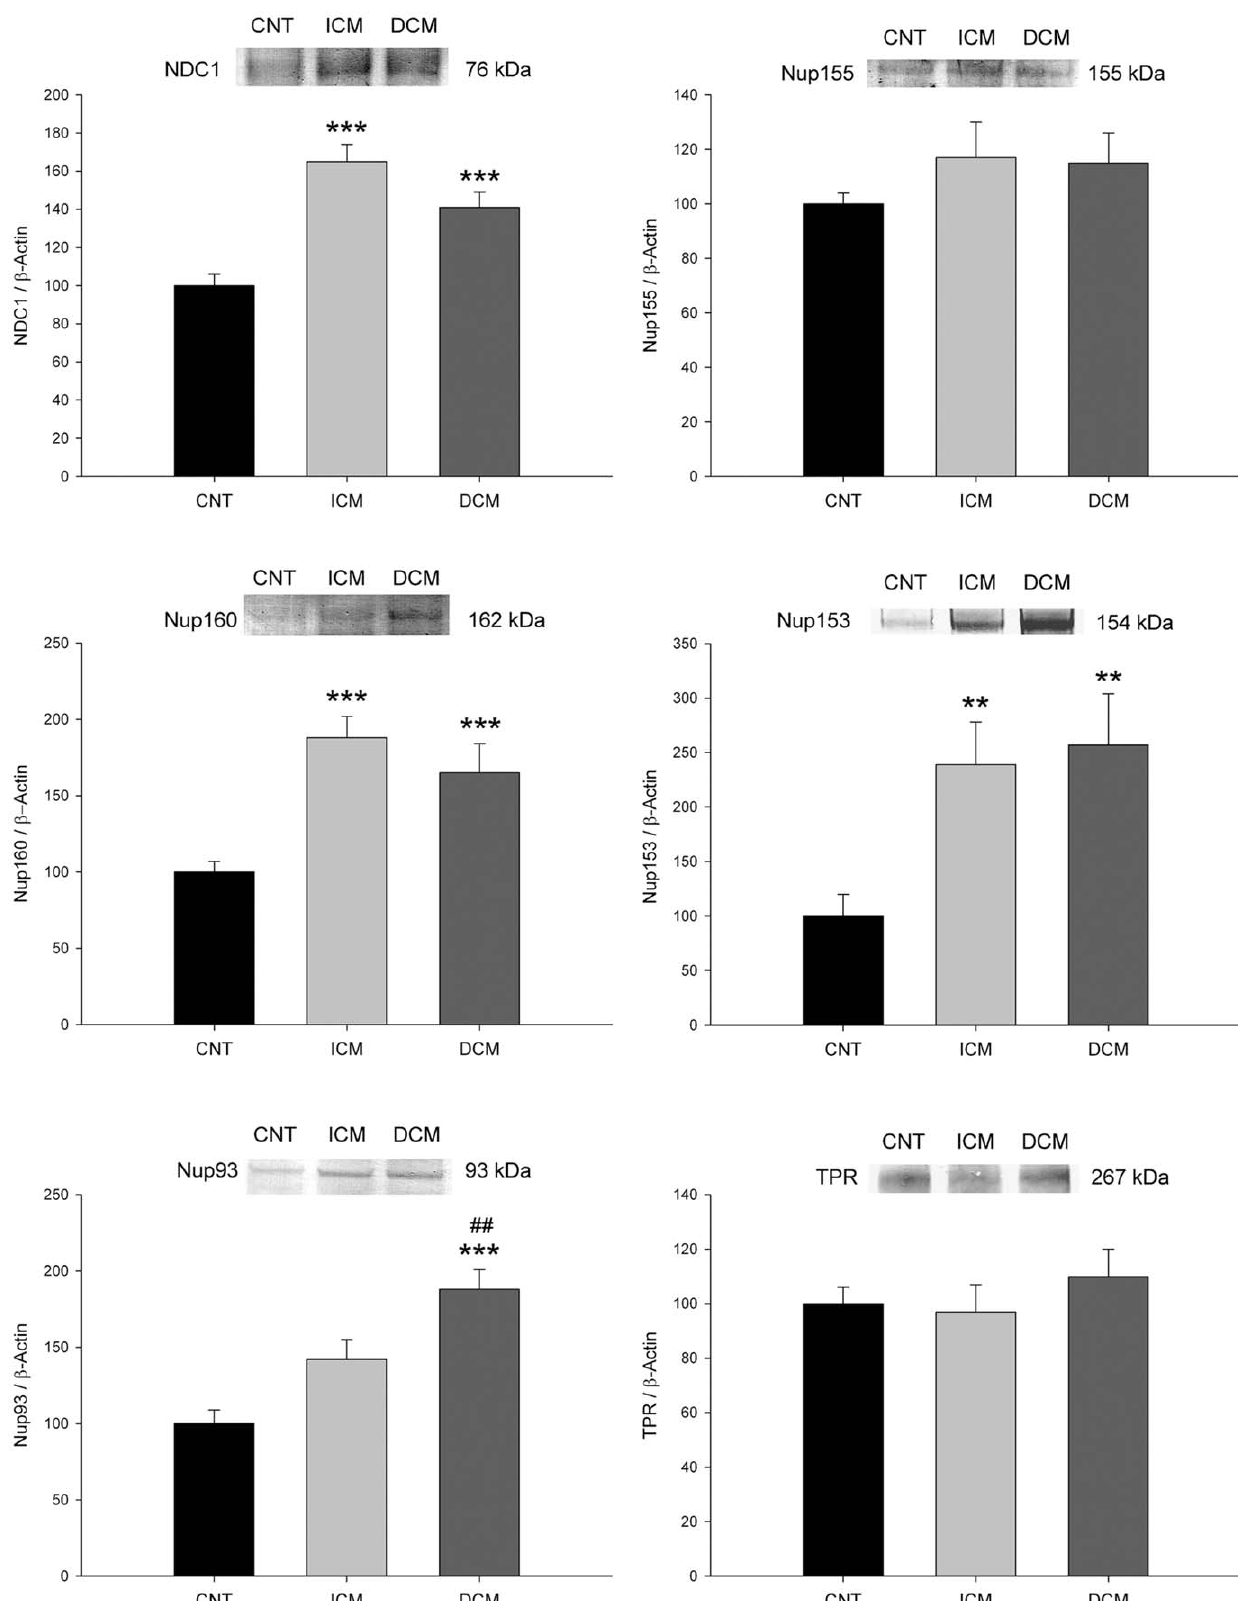
Figure 1. Influence of heart failure aetiology on the levels of nucleoporins. NDC1, Nup155, Nup160, Nup153, Nup93 and TPR were analysed by Western blot techniques. The values from the CNT group were set to 100. The data are expressed as mean 6 SEM in arbitrary units (optical